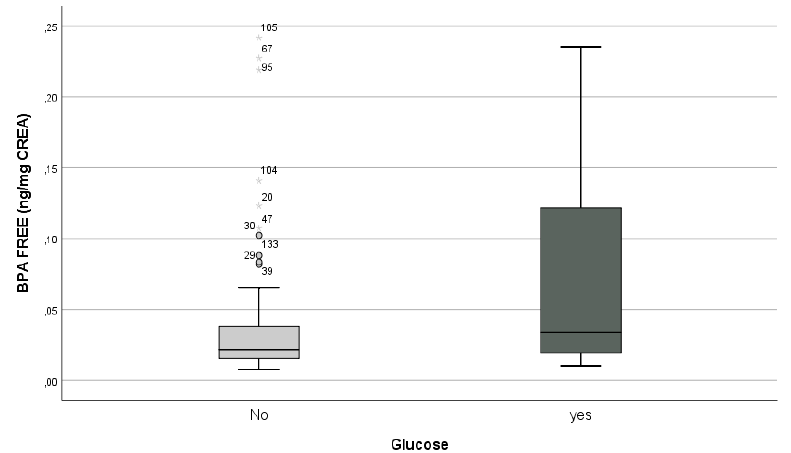
Figure 2. Non-parametric correlations between oral glucose administration and free BPA levels in newborns.